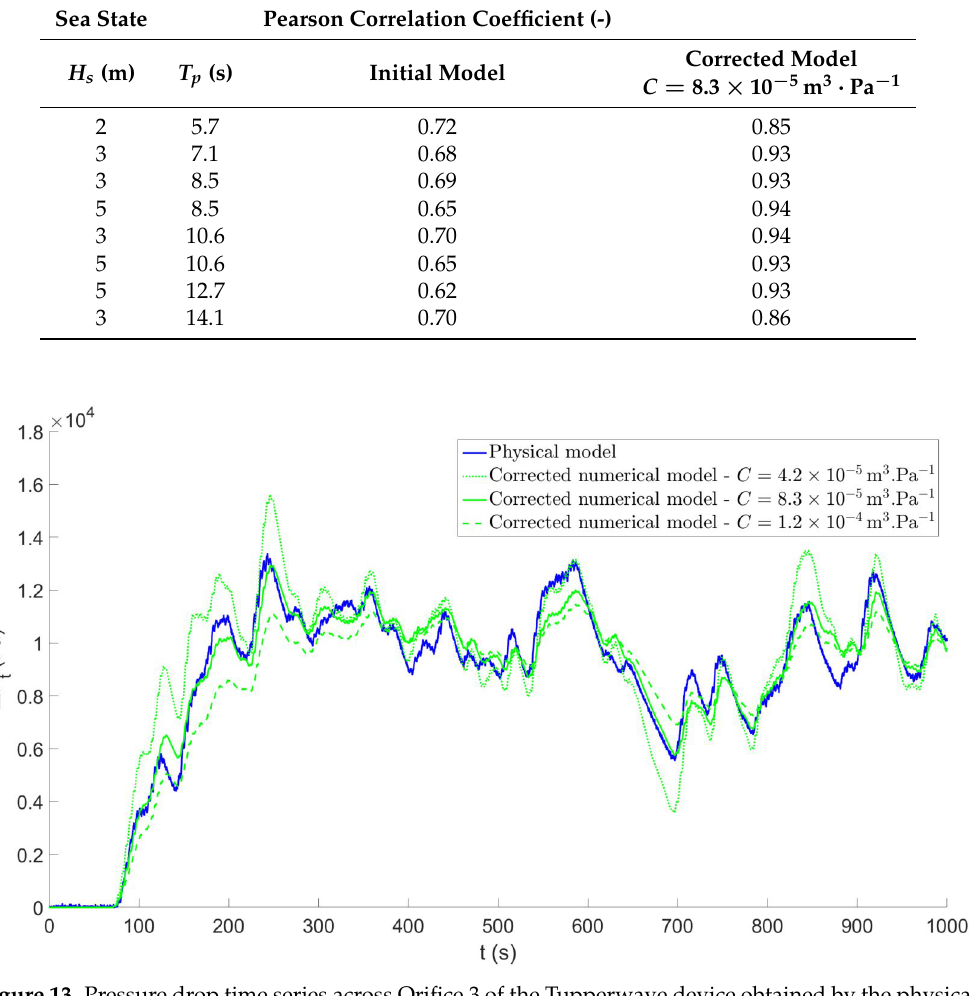
Figure 13. Pressure drop time series across Orifice 3 of the Tupperwave device obtained by the physical model and the corrected model in the irregular sea state { H s = 3 m; T p = 8.5 s} with different chamber stiffness